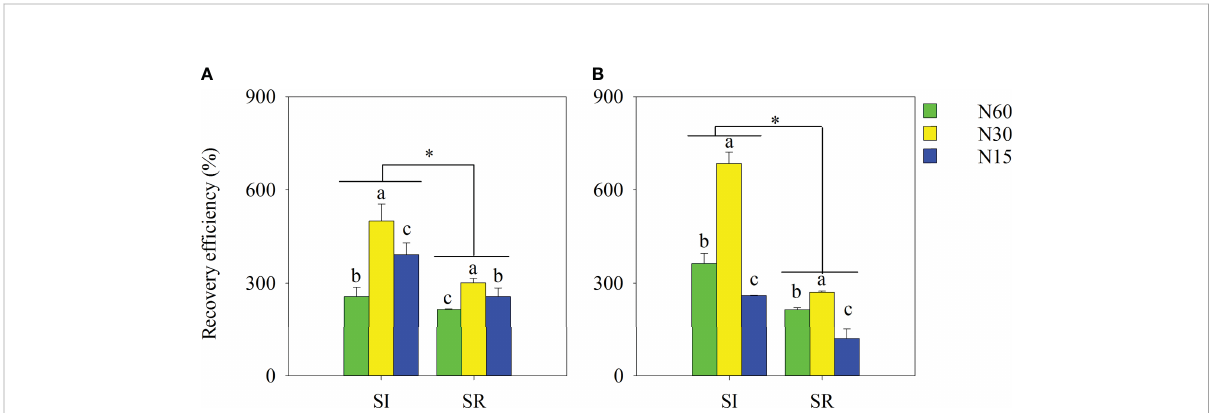
FIGURE 8 Effects of straw incorporation and nitrogen application on N use ef fi ciency of intercropped soybean at the full-maturity stage. Different lower- case letters indicate signi fi cant differences under different N application rates ( LSD , P < 0.05). Data were shown as mean ± S.D. (n=3). The asterisk “ * ” indicates signi fi cant differences ( P < 0.05) between straw incorporation and straw removal. SI, straw incorporation; SR, straw removal; N60, convention N (60 kg N ha -1 ); N30, reduced N by 50% (30 kg N ha -1 ); N15, reduced N by 75% (15 kg N ha -1 ). (A) , the recovery ef fi ciency of soybean in 2019; (B) , the recovery ef fi ciency of soybean in 2020.